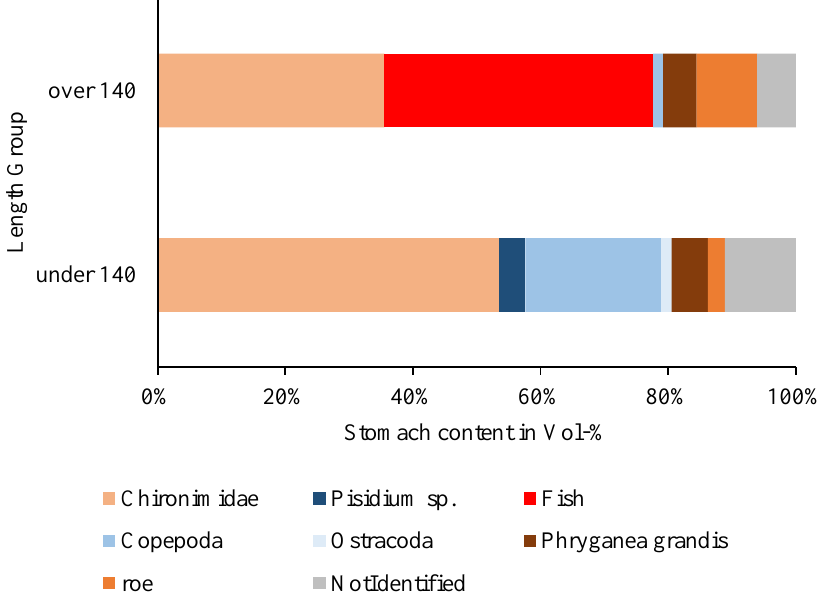
Figure 3. The diet of A. charr individuals larger than 140 mm ( n = 20) compared to the diet of A. charr individuals smaller than 140 mm ( n = 21).